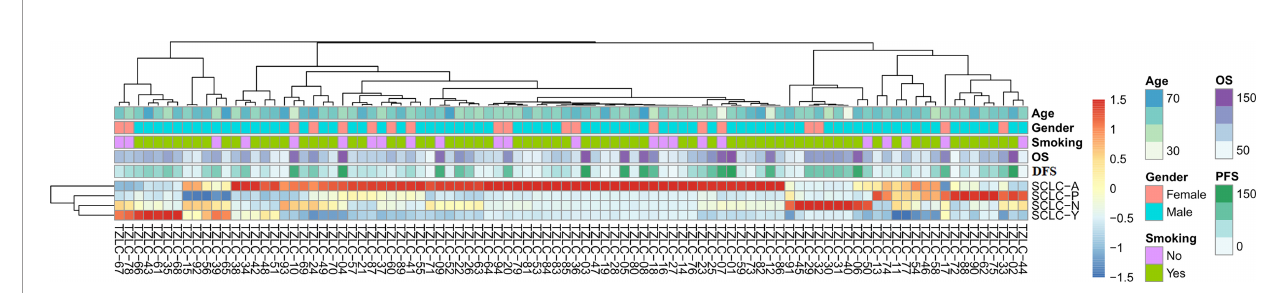
FIGURE 1 | Unsupervised Clustering Analyses of ASCL1, NEUROD1, POU2F3, and YAP1 Gene Expression of Primary Small Cell Lung Cancer Tumors. A total of 94 patients were included to perform this analyses. SCLC-A, SCLC tumors classi fi ed into the ASCL1 subtype; SCLC-N, SCLC tumors classi fi ed into the NEUROD1 subtype; SCLC-P, SCLC tumors classi fi ed into the POU2F3 subtype; SCLC-Y, SCLC tumors classi fi ed into the YAP1 subtype. OS, overall survival; DFS, disease-free survival; ASCL1, achaete-scute homologue 1; NEUROD1, neurogenic differentiation factor 1; POU2F3, POU class 2 homeobox 3; YAP1, yes-associated protein